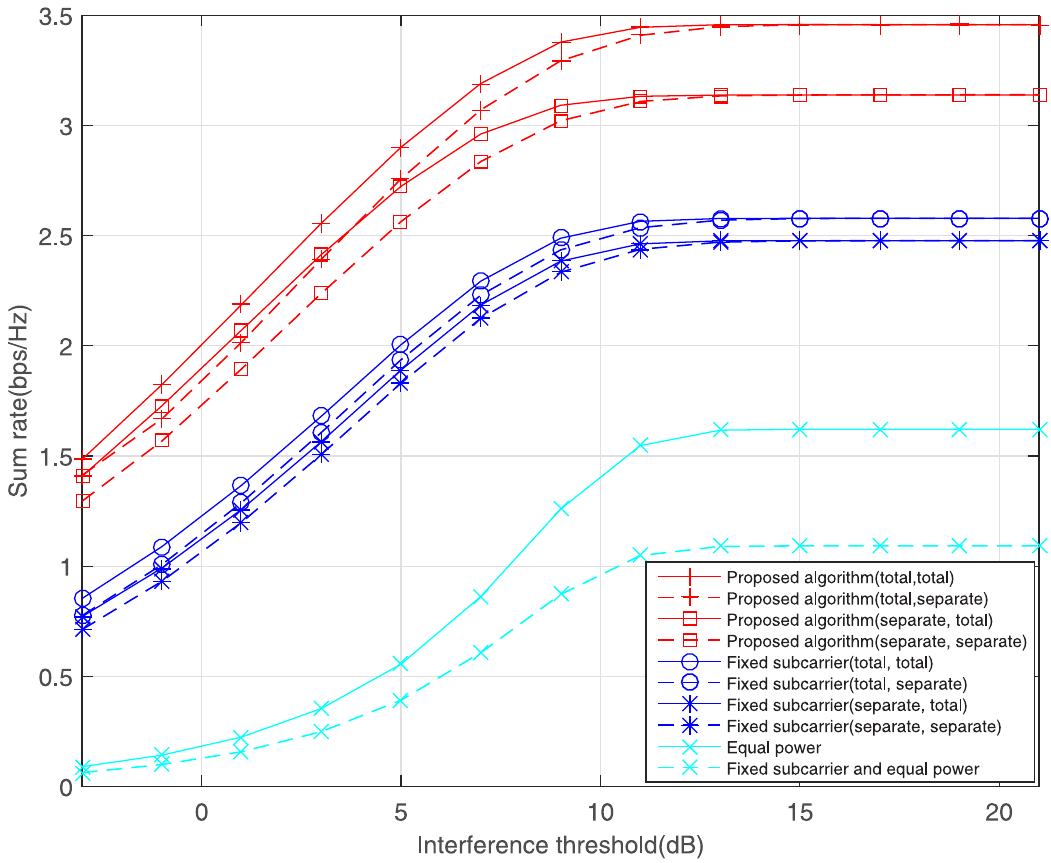
Fig 4. Effect of interference threshold on the sum rate, where average SNR =